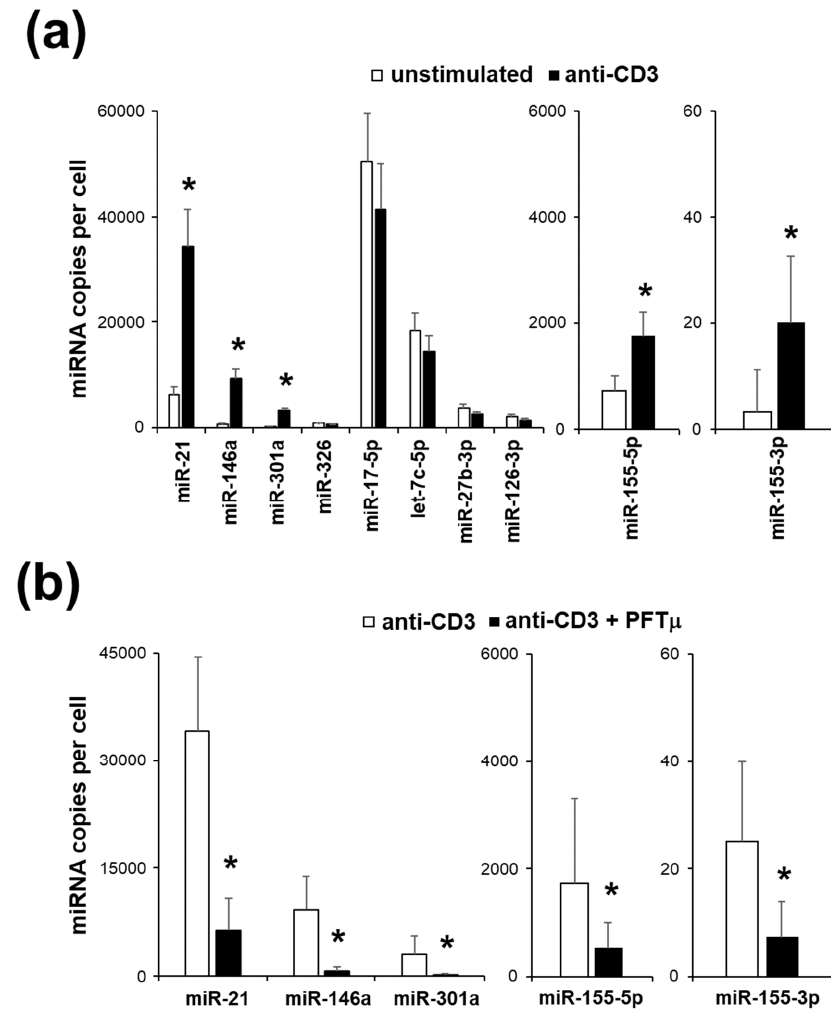
Figure 3. A subset of microRNA (miRNA) is upregulated in EL4 TCR + cells following a T cell receptor (TCR) stimulation. ( a ) Quantification of the miRNA copies per cell in EL4 TCR + cells following an anti-CD3 stimulation. ( b ) Quantification of the miRNA copies per cell in EL4 TCR + cells under anti-